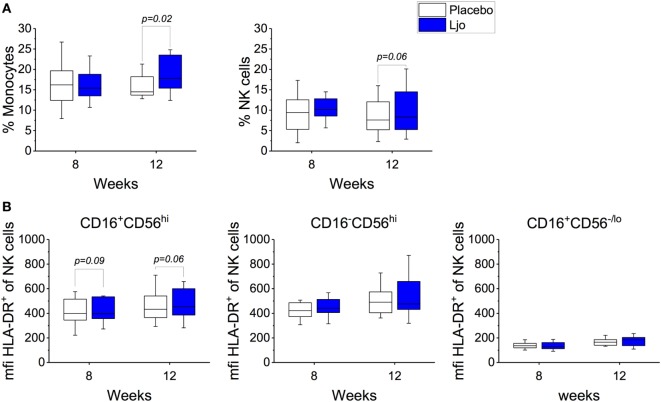
Monocytes and natural killer (NK) cells in healthy subjects. (A) Mononuclear cells (CD3−CD19−) were stained with specific antibodies to define monocytes (CD14+) and NK cells (CD14−) in the placebo and in the L. johnsonii N6.2 (Ljo) groups. (B) Expression of HLA-DR (mfi) in different NK cells subset: CD16−CD56hi, CD16+CD56lo/−, and CD16+CD56hi after 8 weeks of treatment or 12 weeks (4 weeks into the washout). The concentration of cells shown has been normalized to the concentration found at time 0 for each subject.